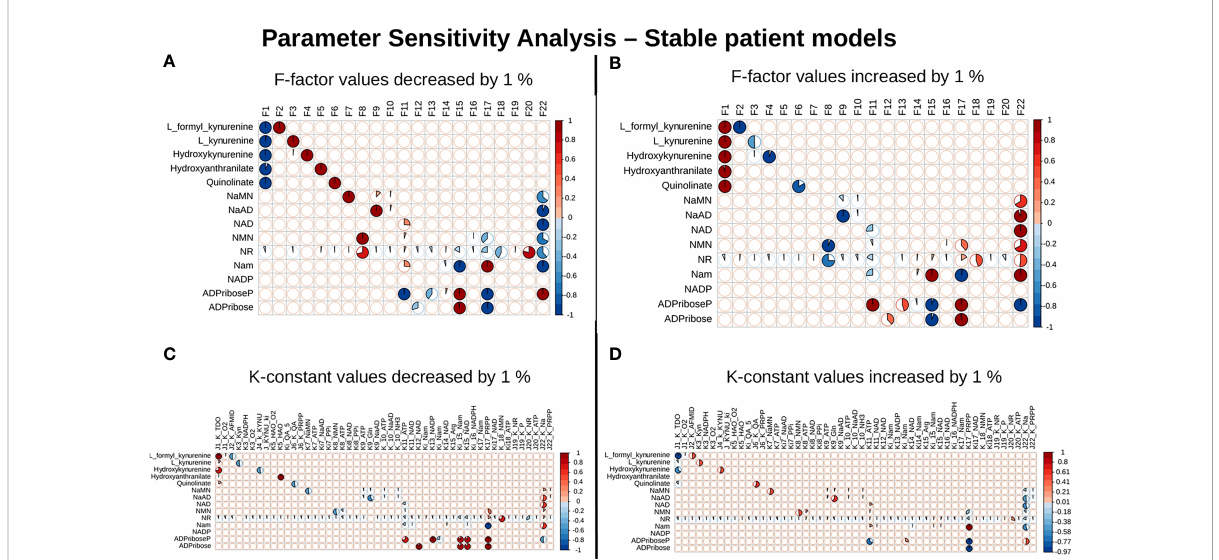
FIGURE 4 NAPRT is the control point in the NAD biosynthesis pathway in HCC patients. Correlogram between Metabolites and F-factors summarising the extent of patients affected with changes in the parameter values by -1 % in F-factors (A) by +1 % in F-factors (B) -1 % in K-constants (C) , and +1 % in K-constants (D) . The X-axis represents the parameters, and the Y-axis represents the metabolites. The red colour represents an increase in concentration and the blue colour represents a decrease in concentration. The area occupied by the coloured pie shows percentage of stable models, with greater than 1 % change in the concentration due to the change in the parameter value, out of 168 stable